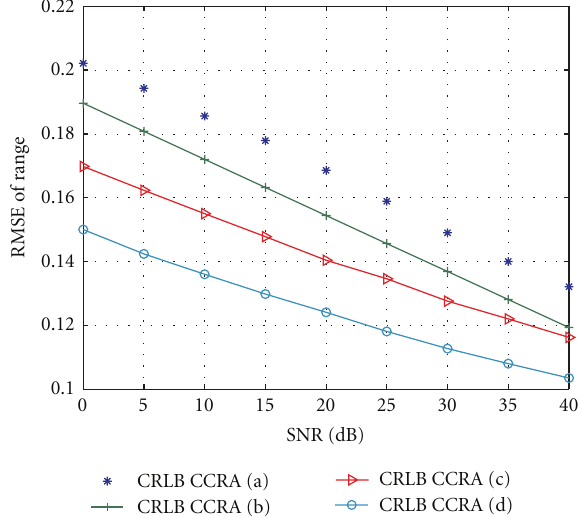
Figure 4: CRLB of estimated range for four di ff erent arrangements: (a), (b), (c), and (d) of